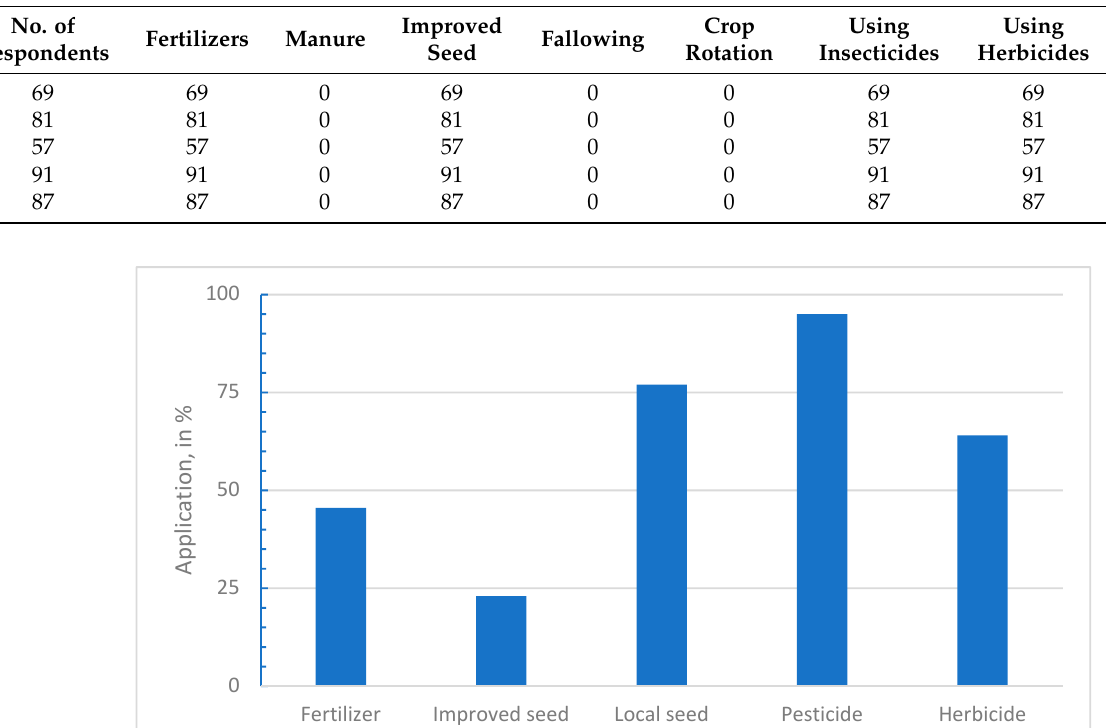
Figure 7. Farmers spraying pesticide close to birds roosting sites.